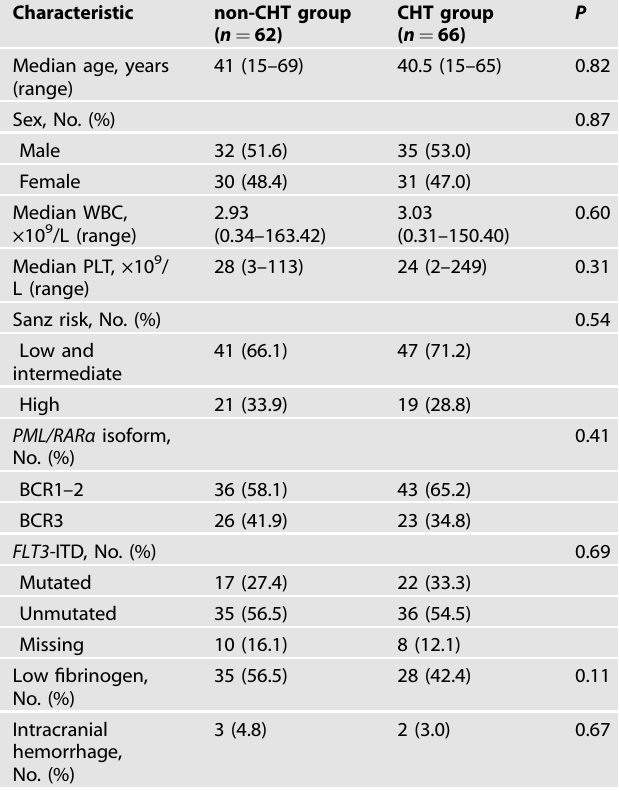
Table 1. Patient characteristics at diagnosis.